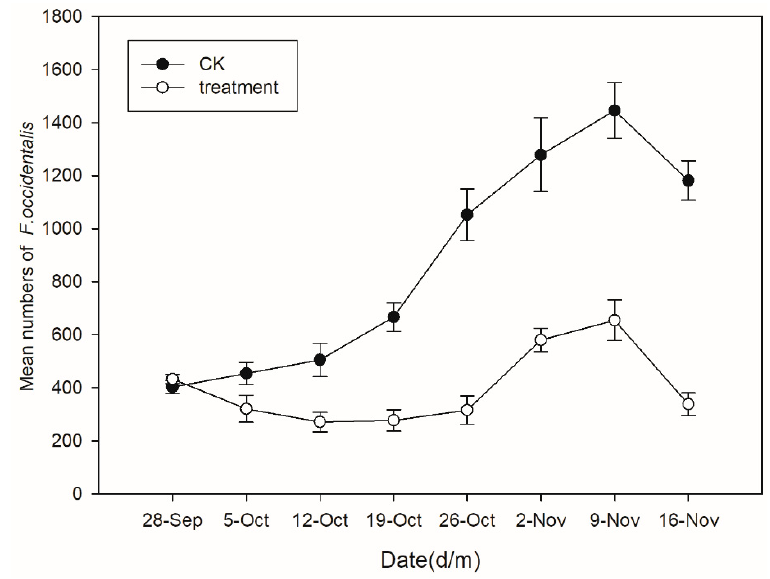
Figure 4. Mean number of Frankliniella occidentalis on greenhouse-grown eggplant soil treated with Beauveria bassiana granules or left untreated.